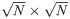
Dependence of the effective triggering rate R
eff on the system size N for a fixed spontaneous triggering probability q = 0.01.1D corresponds to a 1 × N array, 2D corresponds to a N×N array of hexagonal cells. The inset shows the dependence of R
eff on q for a fixed number of cells N = 100.